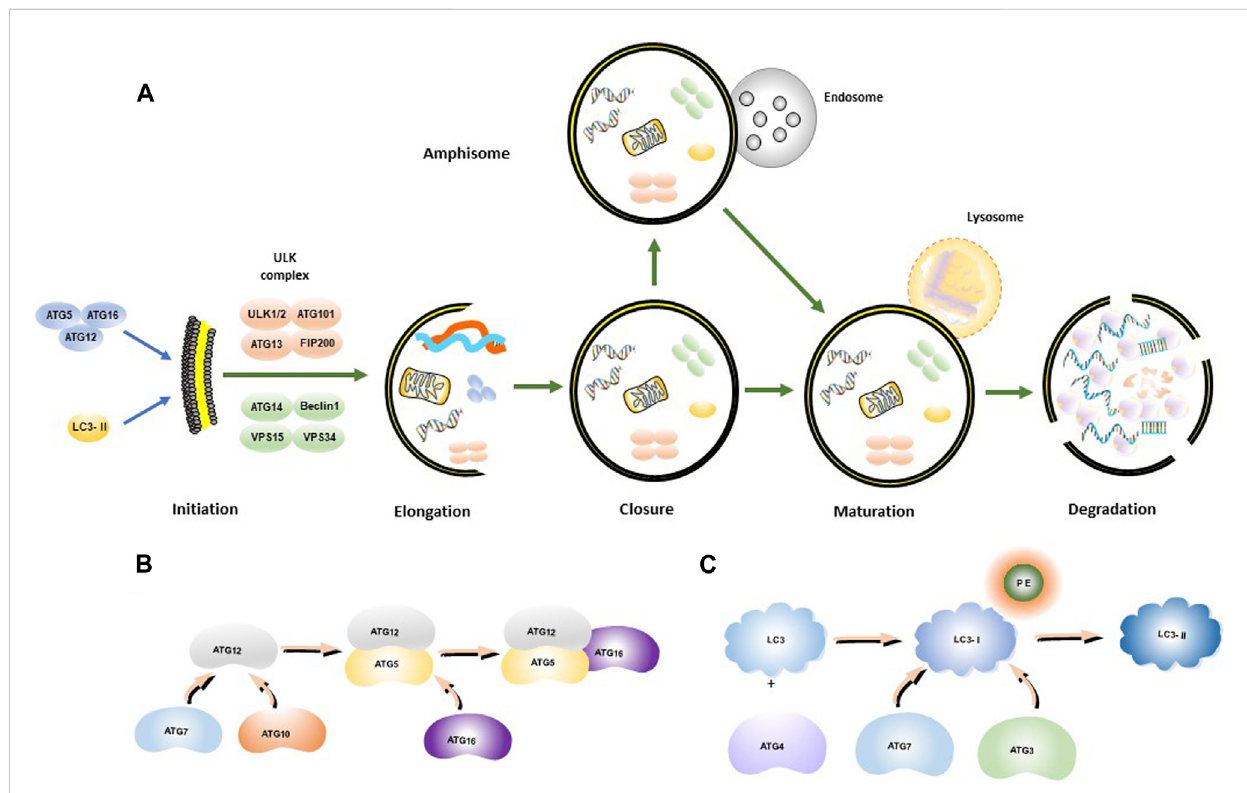
FIGURE 1 Autophagosome synthesis and autophagy process. (A) Schematic model of autophagic fl ux; (B) ATG12-ATG5-ATG16 complex formation process; (C) LC3-II formation process.